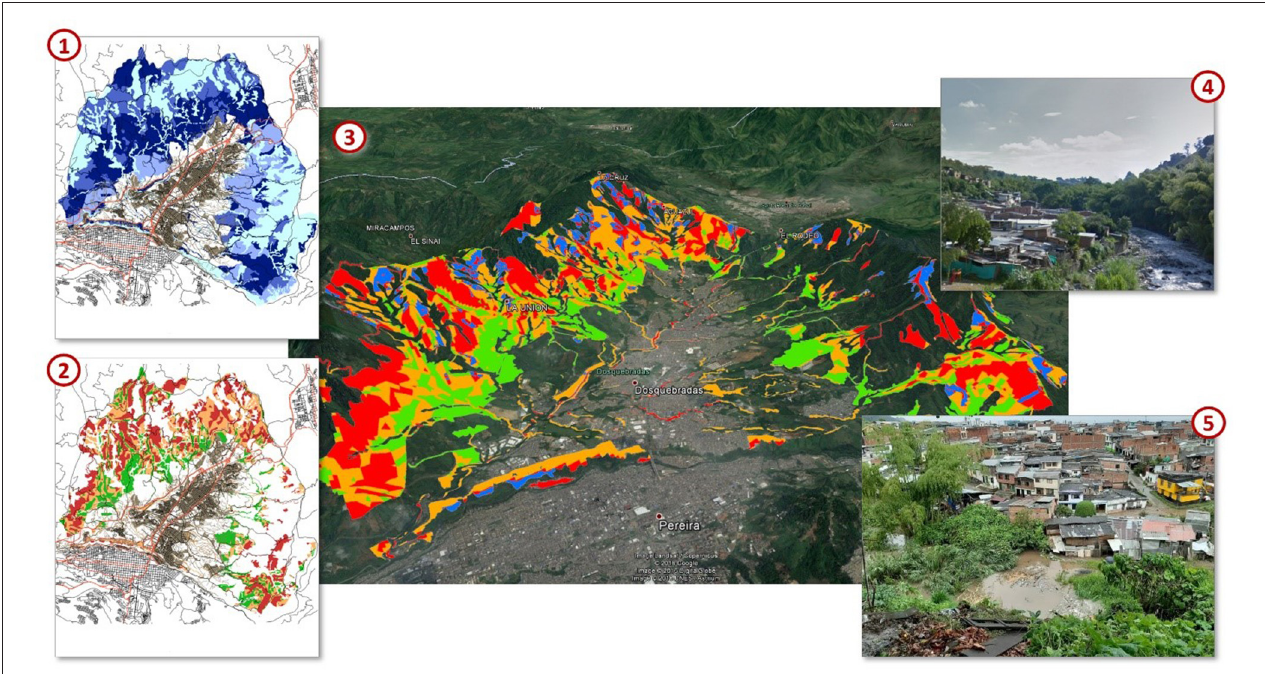
FIGURE 2 | Compilation of maps of Dosquebradas and surrounding mountain areas. These maps were produced during the workshop as a result of dialog with participants. (1) Conflict area where formal zones conflict with actual land use. Darker blue indicates a higher conflict (e.g., biodiversity protection area in the zoning plan which are actually used as intensive pasture). (2) Risk on erosion based on land use, steepness and soil. Red areas have the highest risk, landslides are already occurring under heavy rain (e.g., pastures on steep slopes with a thin sandy soil). Orange areas have less risk and green areas have little erosion risk. (3) Illustrates a draped 3D projection of the combination of map 1 and 2. The blue areas have this biggest conflict (dark blue in map 1) and highest erosion risk (red in map 2). Other red, orange and green areas are taken over from map 2. The blue areas in map 3 were identified as top priority areas to take measures, such as planting trees to reduce erosion risk and enforce the zoning plan. (4) A picture of one of the bigger rivers in the city where houses have been built in the flood zone. (5) A picture of flooding of a small river with steep edges. The river carries a lot of eroded material from the nearby